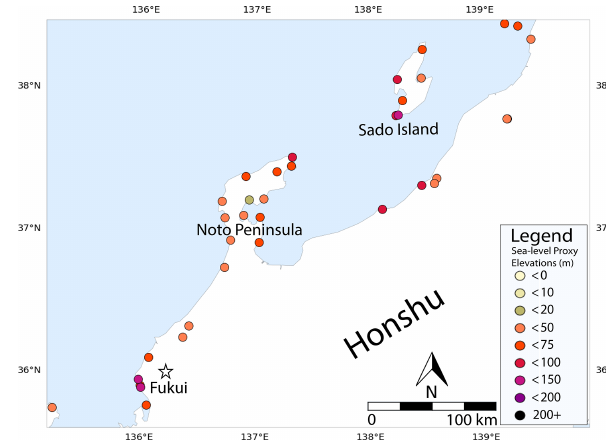
Figure 6. Sea-level elevation proxies in the Kanto region. Sea-level indicators (circles) elevation range indicated by color (see legend). Reference cities are indicated by stars.